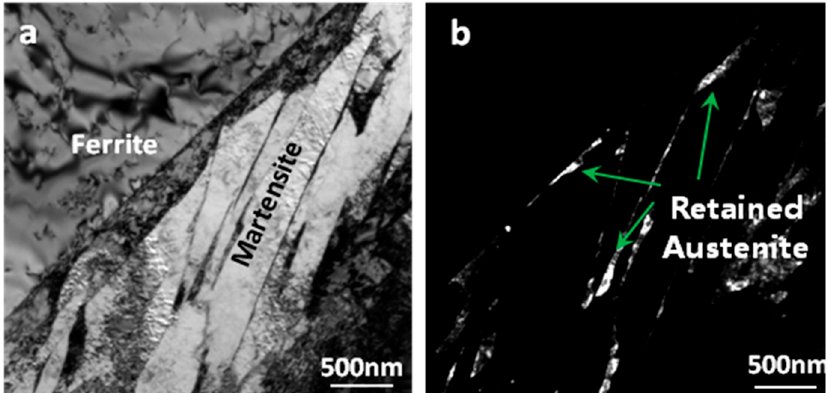
Figure 7. Transmission electron microscopy (TEM) micrographs of Q-P treated specimens: ( a ) ferrite and martensite shown in brightfield and ( b ) retained austenite shown in black field.